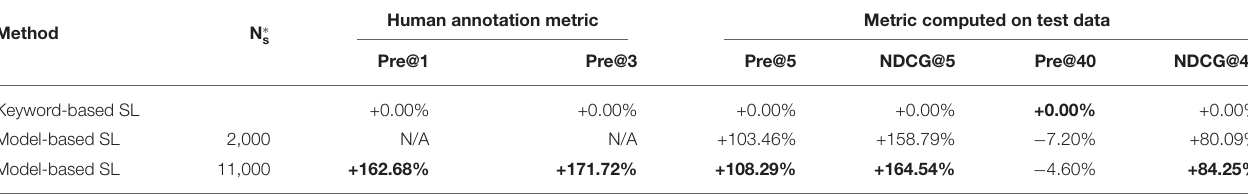
TABLE 1 | Summarization of shortlister models’